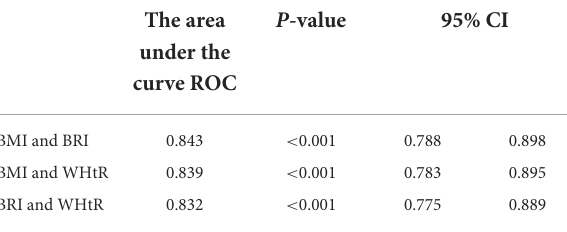
TABLE 8 Area under the curves (AUC) for the various combinations of two anthropometric indices for identifying MetS. P -value 95% CI The area under the curve ROC BMI and BRI 0.843 < 0.001 0.788 0.898 BMI and WHtR 0.839 < 0.001 0.783 0.895 BRI and WHtR 0.832 < 0.001 0.775 0.889 BMI, Body Mass index; WC, Waist circumference; WHtR, waist-to-height Ratio; BRI, body roundness index; MetS, metabolic syndrome. HDL-C, high-density